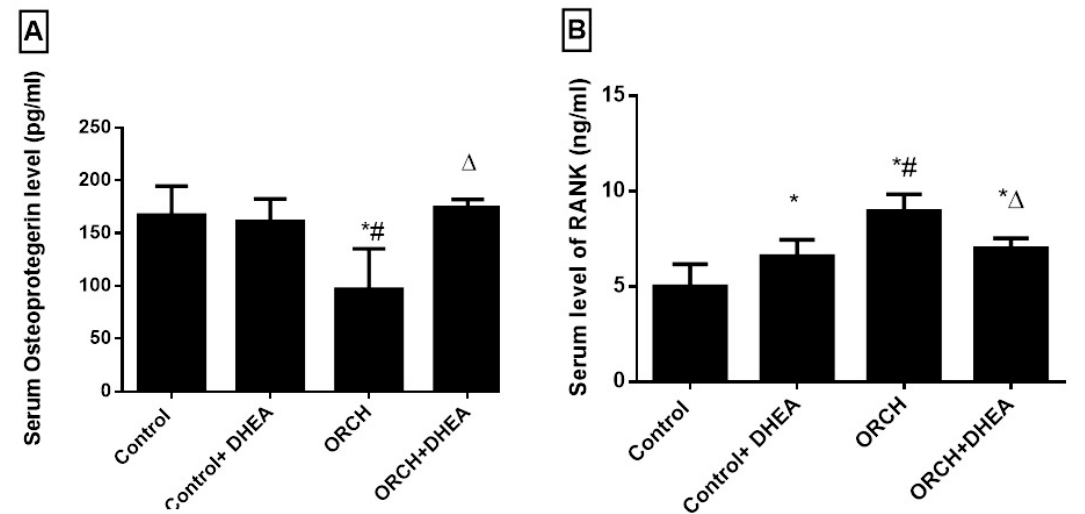
Figure 3. Effect of orchidectomy and DHEA treatment on serum levels of ( A ) OPG and ( B ) RANK. Data were expressed as mean ± SD of 8 rats. *: p < 0.05 versus control, #: p < 0.05 versus control + DHEA, ∆ : p < 0.05 versus ORCH. ORCH: orchidectomy, OPG: osteoprotegrin; RANK: receptor activator of nuclear factor kappa B.